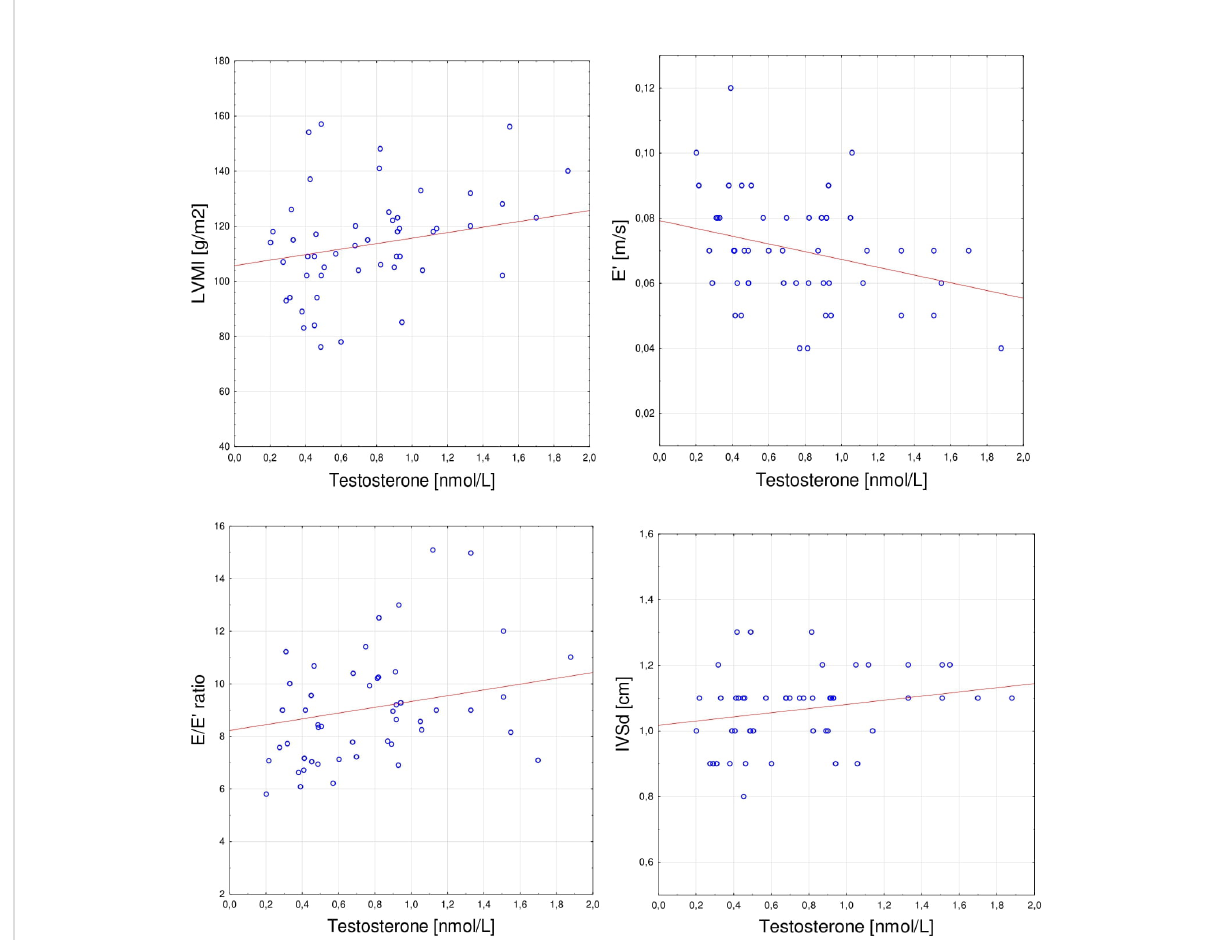
FIGURE 1 Spearman ’ s correlations between serum testosterone level and (A) LVMI (r= 0.285, p < 0.05), (B) E ’ (r= -0.301, p < 0.05); (C) E/E ’ ratio (r= 0.301, p < 0.05); (D) IVSd (r= 0.293, p < 0.05). LVMI, left ventricular mass index; E ’ , average early diastolic mitral annular velocity; E/E ’ ratio, average ratio of early mitral diastolic in fl ow velocity to early diastolic mitral annular velocity; IVSd, interventricular septal diastolic